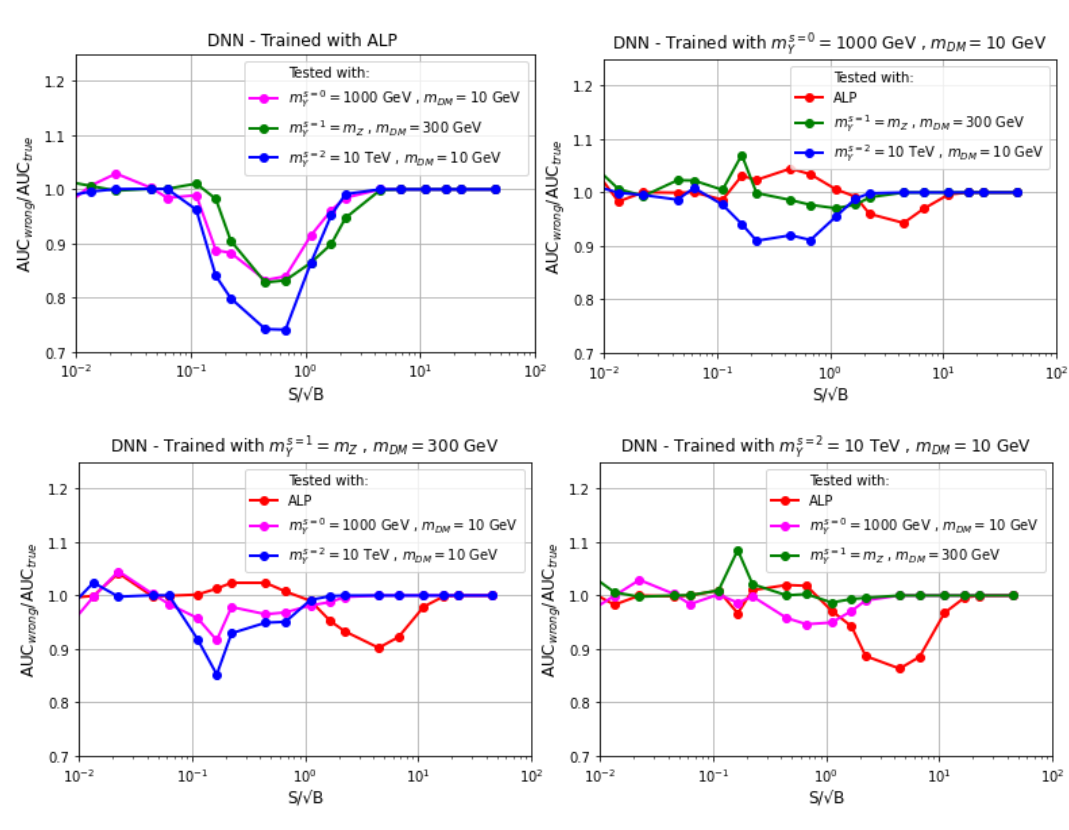
Figure 12: Ratio of the AUCs for non-matching train and test data samples, generated with different benchmark models. Test samples generated with several models, as indicated on each label, are applied to a DNN trained with a particular benchmark: ALP (top-left), spin-0 mediator (top-right), spin-1 mediator (bottom-left), and spin-2 mediator (bottom-right), as indicated on top of each